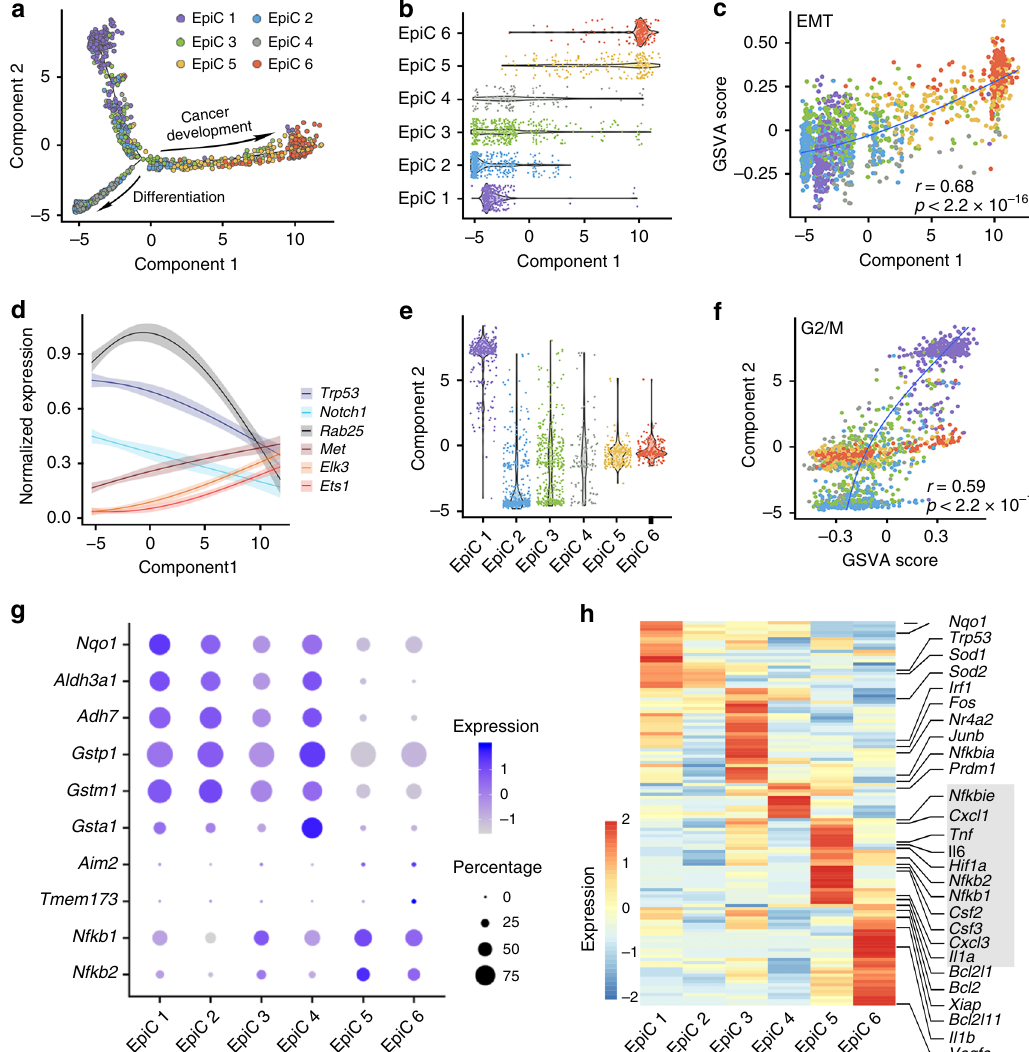
Fig. 3 Characterization of epithelial cell transitions and key pathway changes. a Pseudotime trajectory over epithelial cells in a two-dimensional statespace. Cell orders are inferred from the expression of the most dispersed genes across epithelial cell populations. b Violin plots of the distribution of the component 1 values across epithelial clusters. c Correlation between EMT pathway enrichment scores and component 1 values of single cells. d Normalized expression of six selected ESCC driver genes, methylation dysregulation genes, and transcription factors, smoothed over pseudotime component 1 using LOESS regression. Shaded regions indicate 95% con fi dence interval with a line indicating the mean gene expression. e Violin plots of the distribution of the component 2 values among sub-clusters. f Correlation between G2/M pathway enrichment scores and component 2 values of single cells. g Bubble plot showing expression levels of the genes related to response to 4NQO treatment across six cluster. Size of dots represents the percentage of cells expressing the gene; color scale shows the average expression level. h Heatmap displaying scale normalized expression level of genes in NF- κ B signaling across the six epithelial